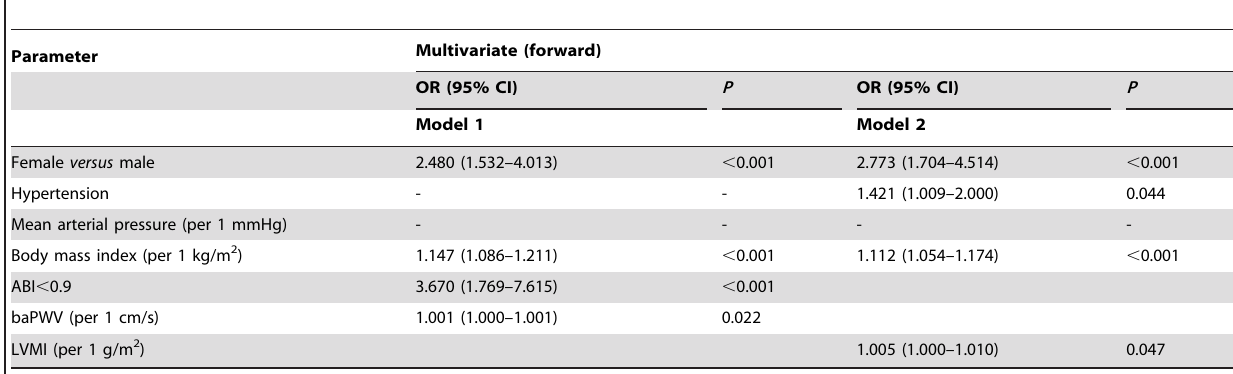
Table 3. Determinants of differences in systolic blood pressure between arms $ 10 mmHg in study patients.